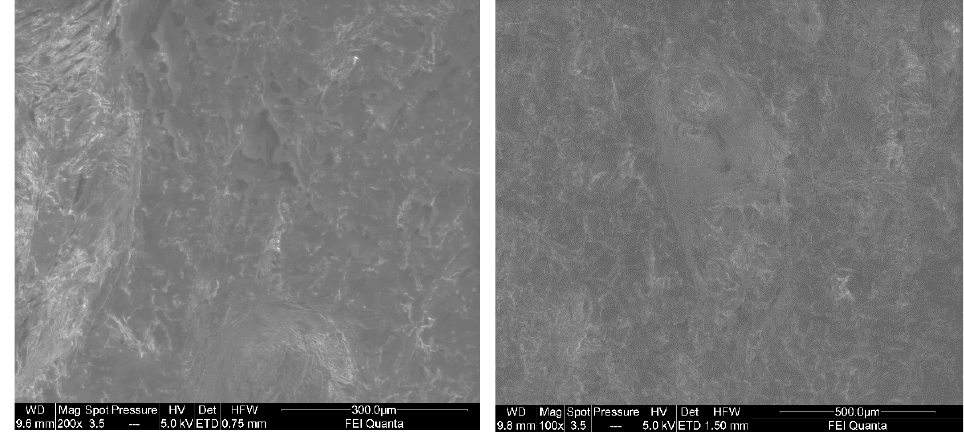
Figure 8. Secondary electron topographic images of the sample section.